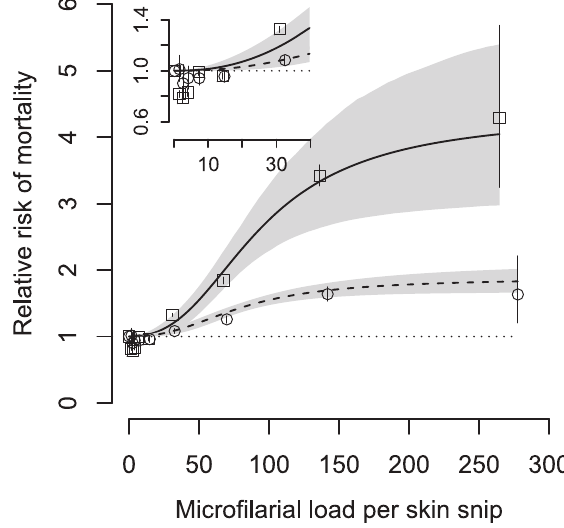
Figure 2. Observed and fitted relative mortality risk with Onchocerca volvulus microfilarial skin load according to age- group. Individuals , 20 years old (open squares and solid line respectively); individuals $ 20 years old (open circles and dashed line respectively). The fitted sigmoid dose-response model is adjusted to the average age of the respective age groups. Shaded (grey) areas around the fitted lines represent 95% Bayesian credible intervals; error bars represent 95% confidence intervals around observations. Inset permits visual inspection of the mortality relative risk at parasite loads # 40 microfilariae per skin